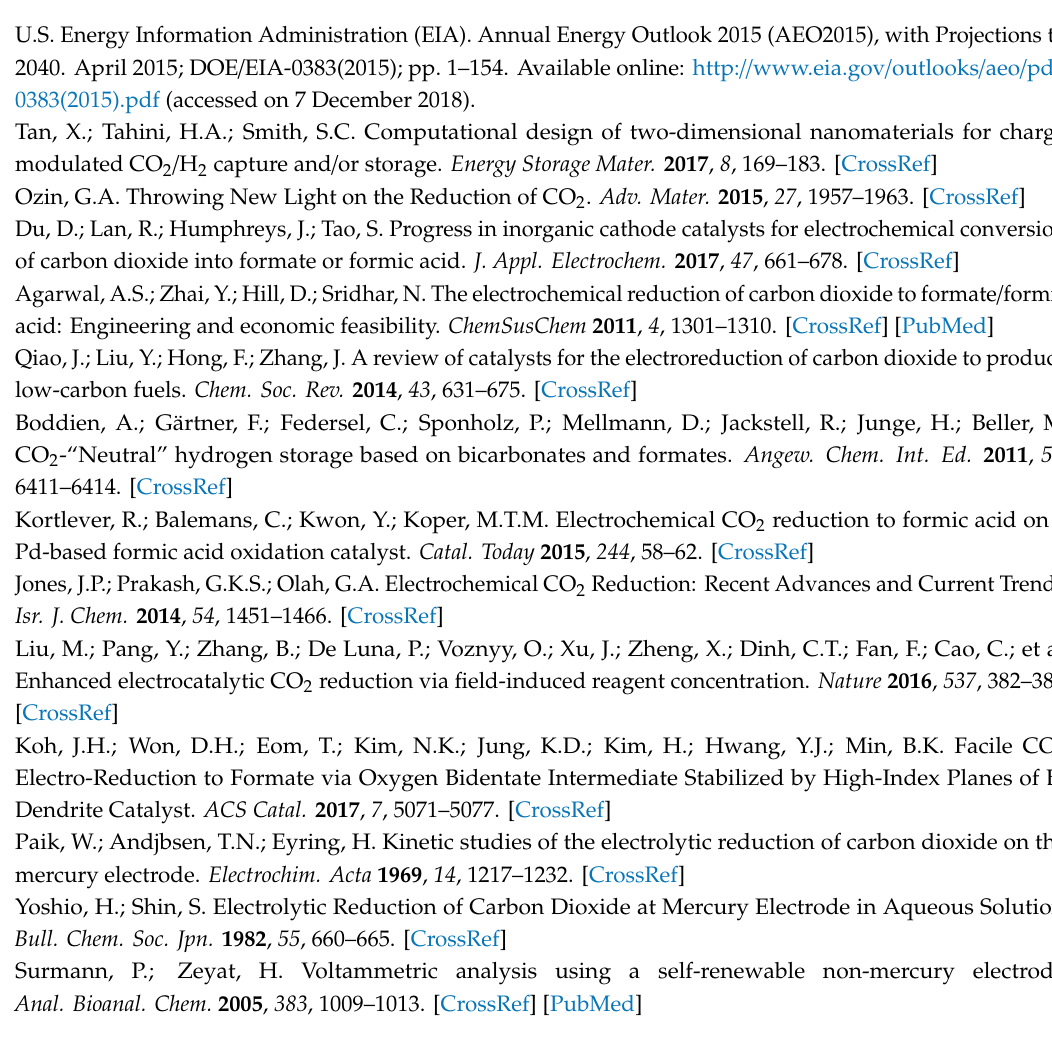
Figure S1: Experimental setup (Scheme) for electrochemical CO 2 reduction measurements, Figure S2: Formate current density of Pd, PdHg100, PdHg200 and PdHg800 at the potential range of − 1.7 to − 2.3 V vs SCE, Figure S3: XRD patterns of Pd, PdHg100, PdHg200 and